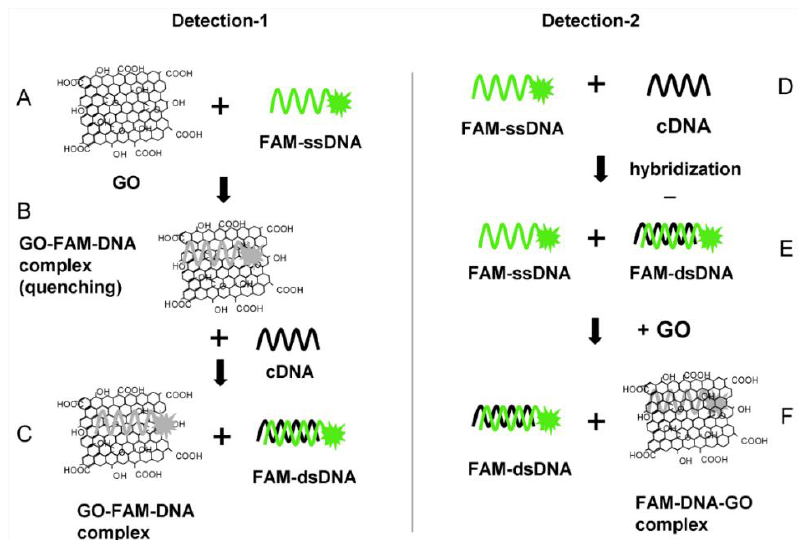
Figure 1. Schematic representation of oligonucleotide detection via hybridization to ssDNA probe adsorbed to a graphene oxide (GO) surface (detection-1) or in solution (detection-2). ( A ) The fluorescein-conjugated single stranded probe (FAM – ssDNA) mixed with graphene oxide (GO), results in ( B ) probe surface adsorption and fluorescence quenching. The addition of a complementary cDNA target (cDNA) results in ( C )